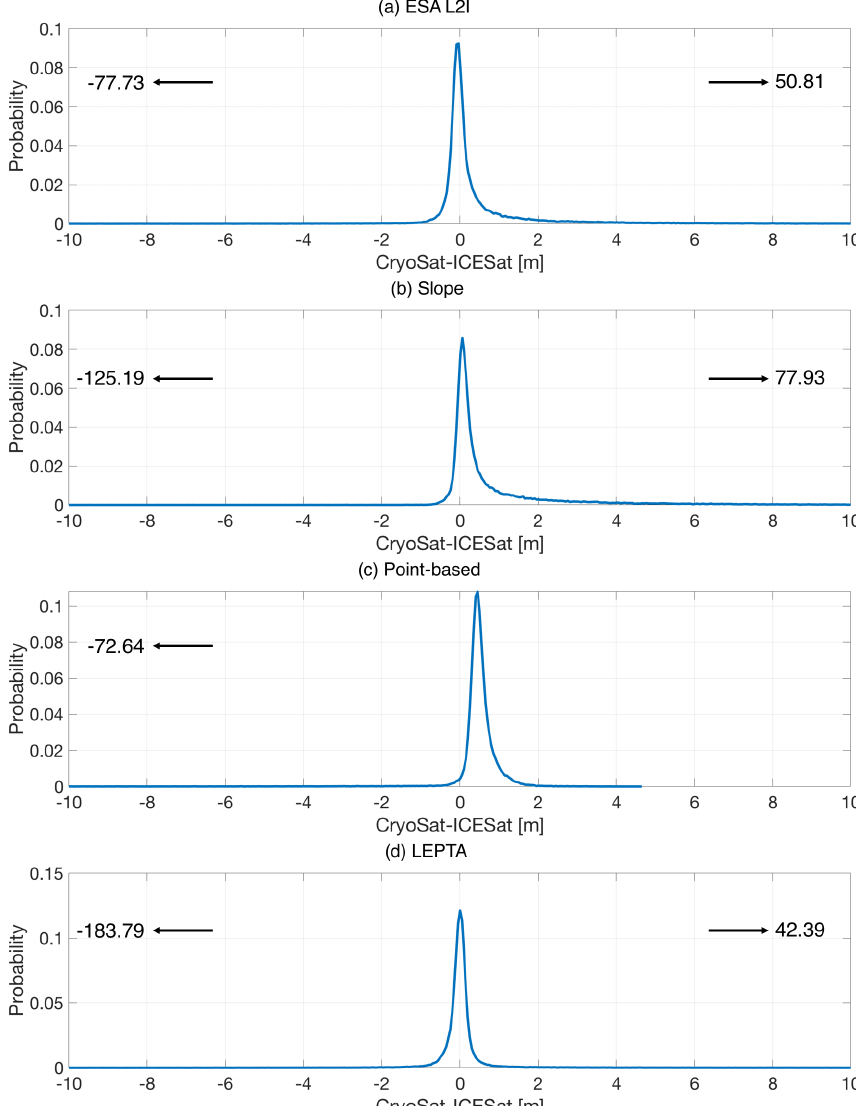
Figure B2. Probability distribution functions of heights between CryoSat-2 and ICESat-2 derived from (a) ESA L2I, (b) the slope method, (c) the point-based method, and (d) LEPTA centred between − 10m and 10m. To clearly show minimum and maximum values (values displayed with arrows), the curves are not displayed in the same